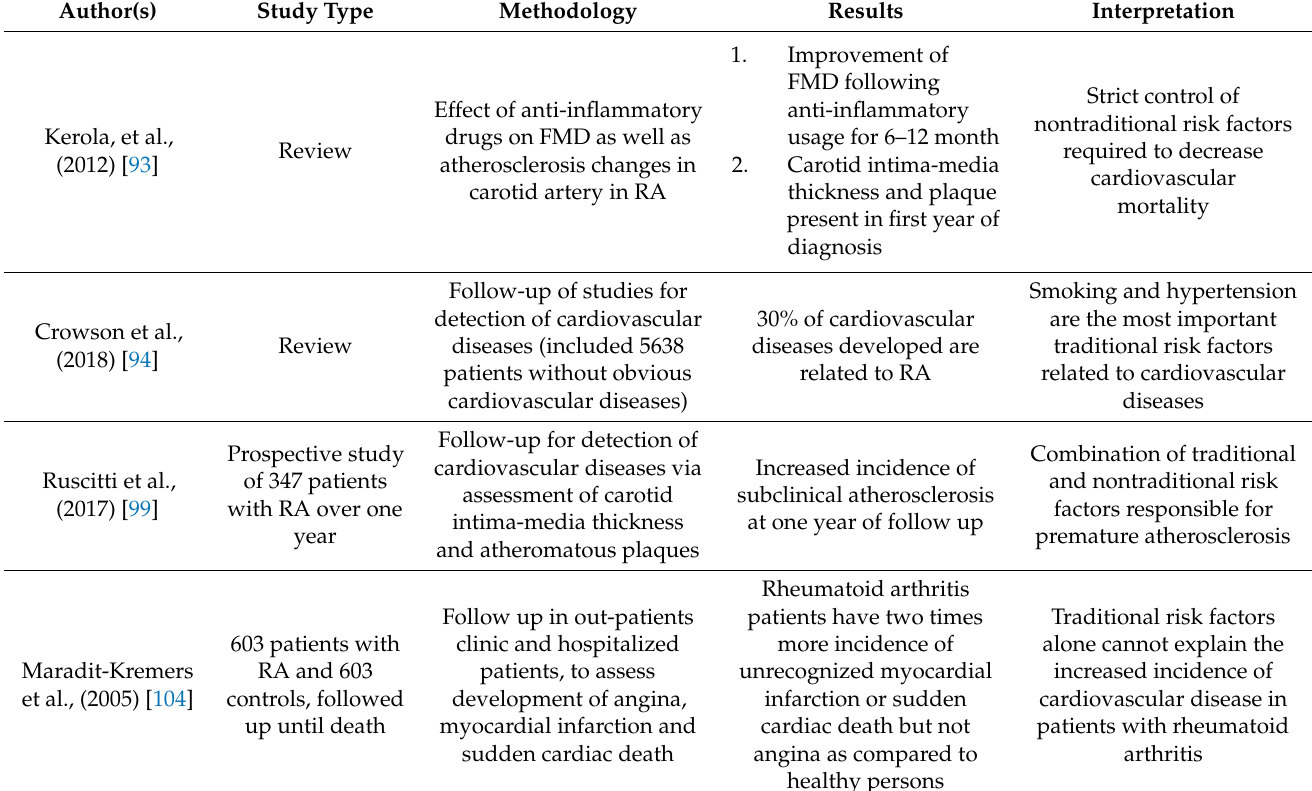
Table 1. An outline of different studies that examined effects of autoimmune rheumatic diseases on vascular function and assessed risk of accompanying atherosclerosis and development of cardiovascular